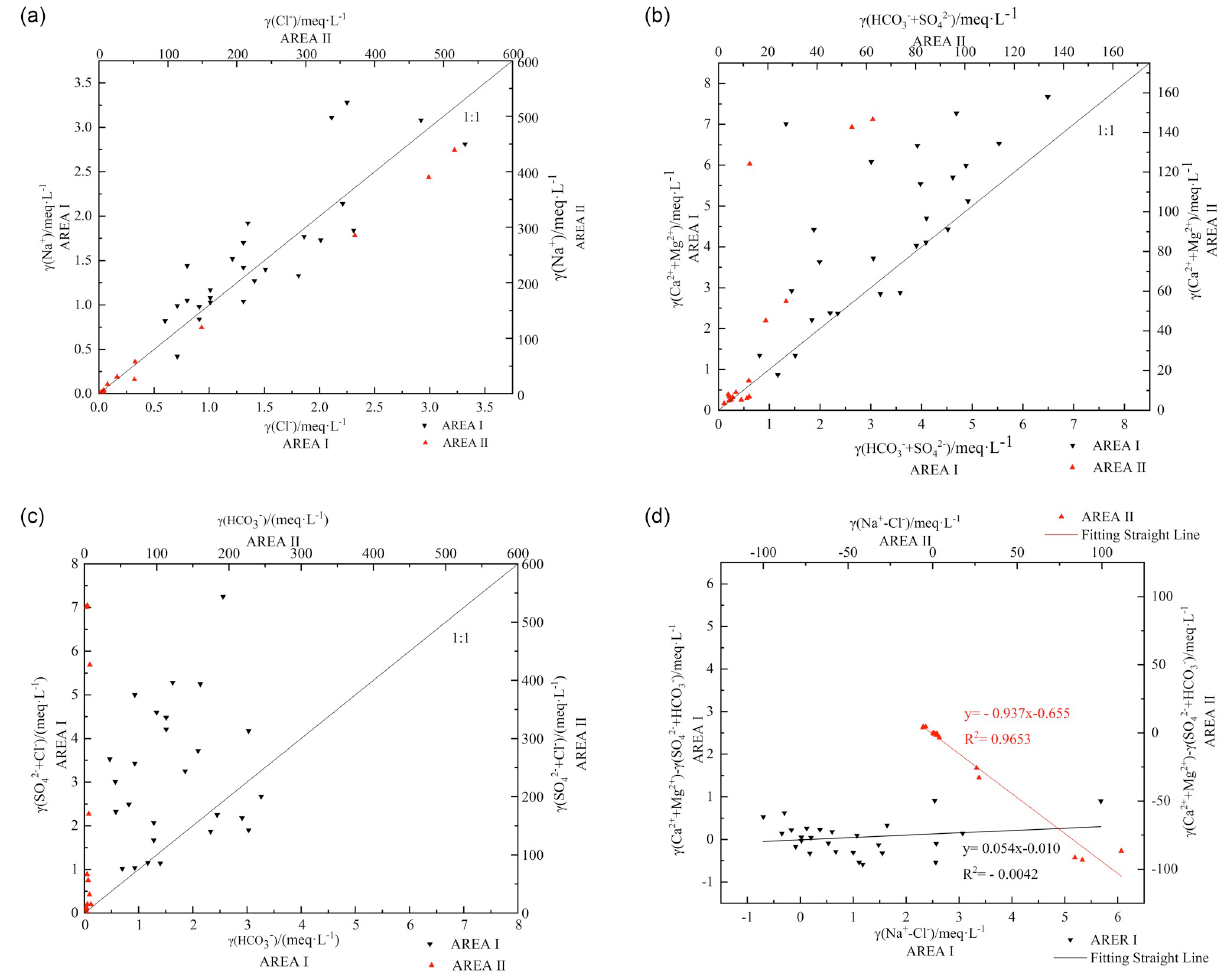
Fig 5. Ion proportional coefficient diagrams of the study